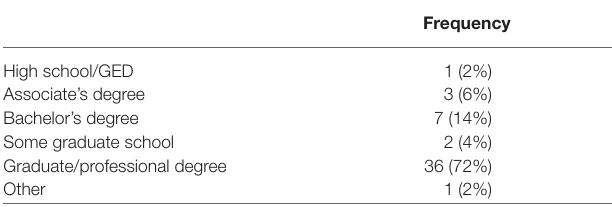
TABLE 2 | Primary parent education (Method